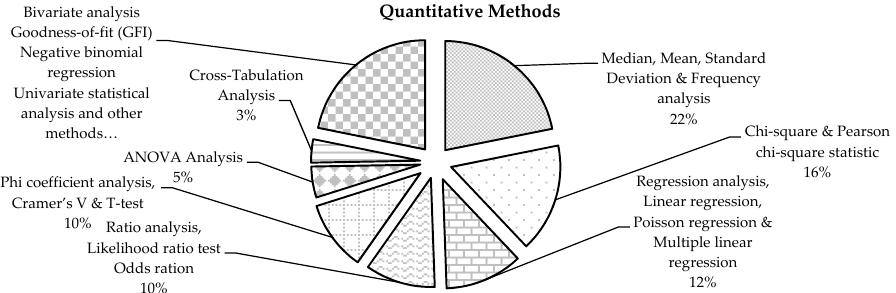
Figure 4. Quantitative approaches/methods used in the data analysis.